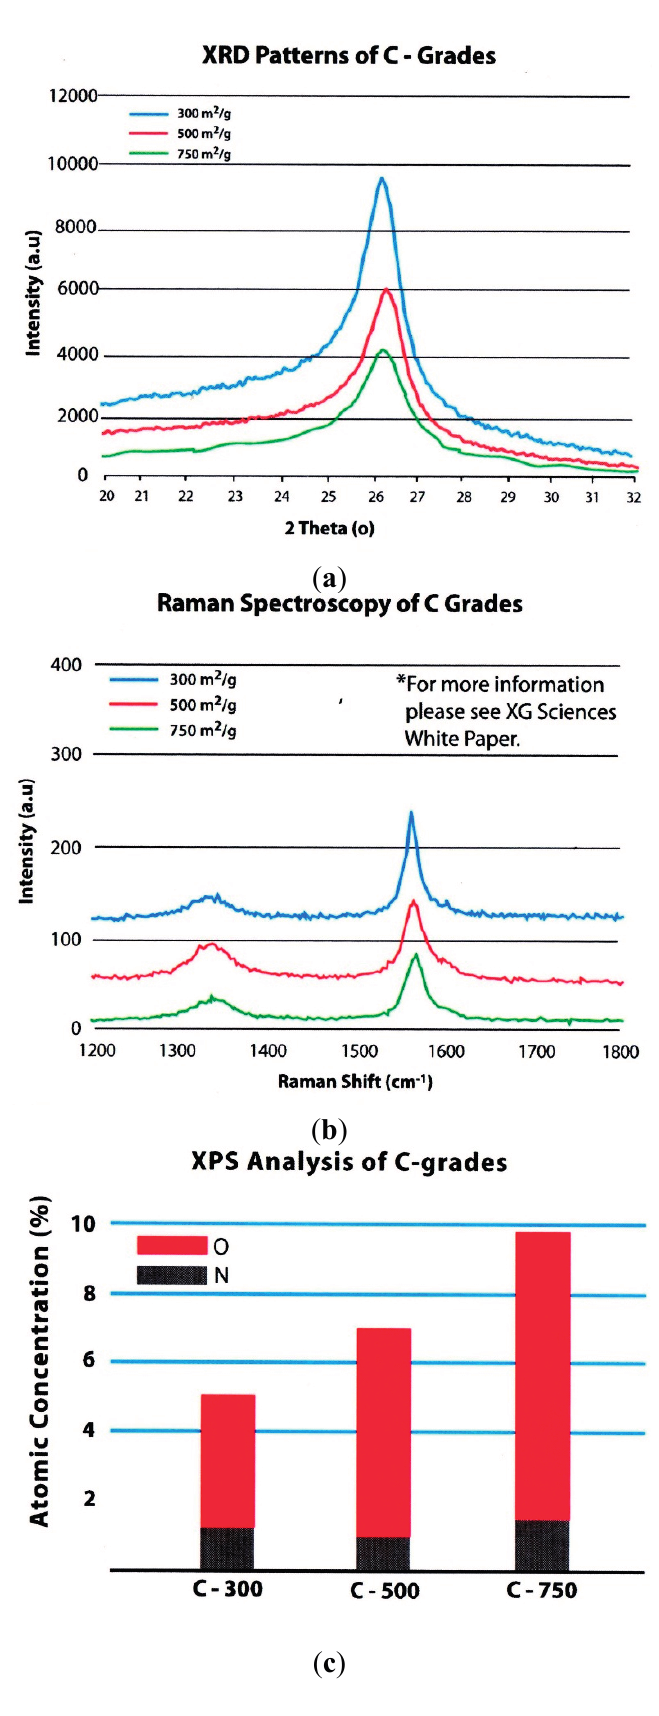
Figure 1. XRD ( a ), Raman ( b ) and XPS ( c ) of the as-received graphene